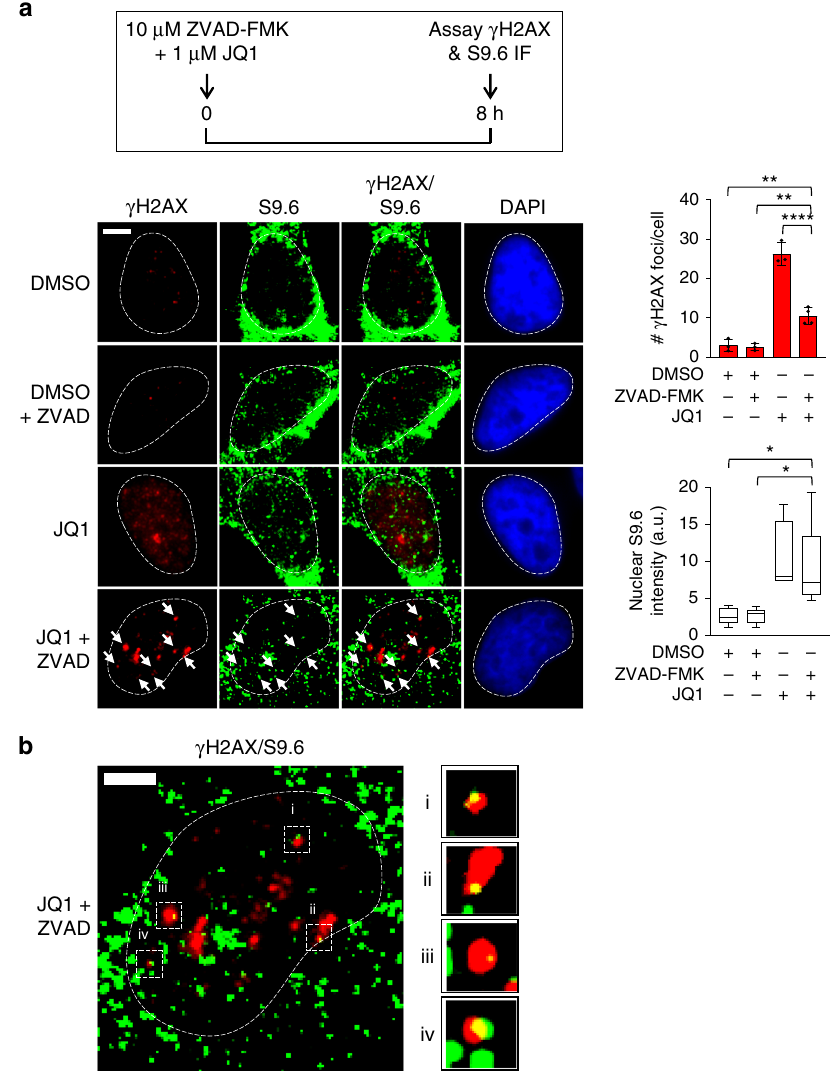
Fig. 6 DNA damage occurs at a subset of R-loops in cells following BRD4 inhibition. a Upper panel: experimental design. Lower left panel: IF images of γ H2AX and S9.6 fl uorescence in HeLa cells treated with 10 μ M ZVAK-FMK, 1 μ M JQ1, or co-treated for 8 h. Lower right panel: quanti fi cation of γ H2AX foci and nuclear S9.6 intensity per cell. Data presented as mean ± SEM ( n = 3 separate experiments). Signi fi cance assessed using ANOVA followed by Tukey ’ s test ( γ H2AX DMSO vs ZVAD-FMK + JQ1 **Adjusted P = 0.0044; γ H2AX ZVAD-FMK + DMSO vs ZVAD-FMK + JQ1 **Adjusted P = 0.0031; γ H2AX JQ1 vs ZVAD-FMK + JQ1 ****Adjusted P < 0.0001;